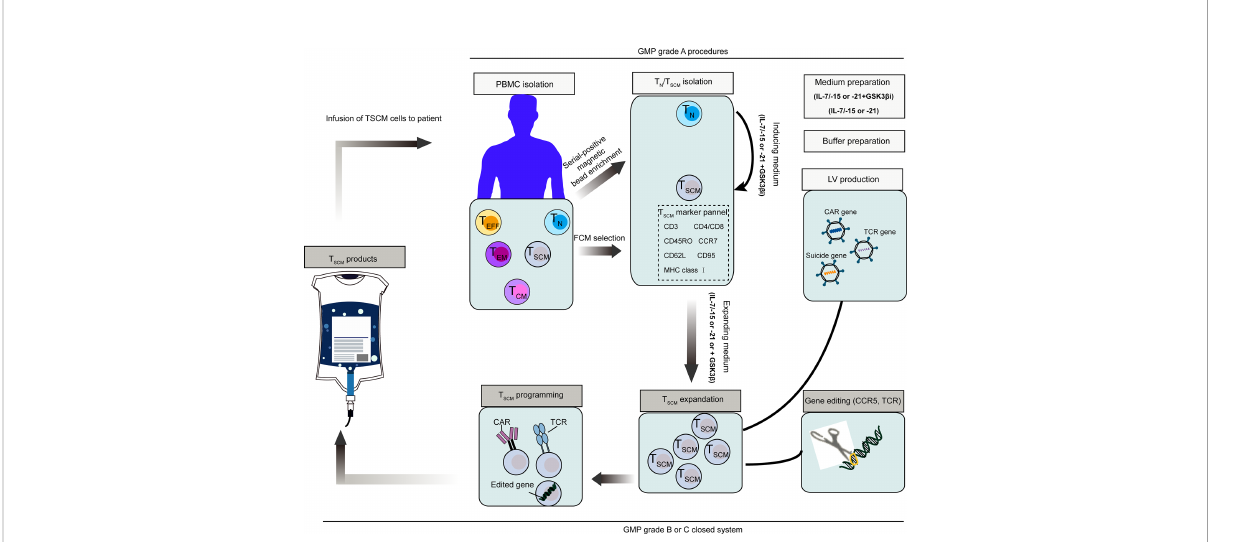
FIGURE 6 Schematic representation of clinical stem cell memory T (T SCM ) cells product and programming process (26, 75, 243). Naïve T (T N) cells were then stimulated to transform to T SCM cells with IL-15, IL-21 and IL-7. To maximize the induction of T SCM , GSK-3 b inhibitor can be used in addition to the above cytokines. T SCM cells can be also isolated directly from PBMCs by a set of markers. Representative programming methods include introducing exogenous genes like speci fi c CAR, TCR and suicide genes, or directly editing endogenous genes. Requirements of GMP grade for main procedures are indicated in the fi gure. PBMC, peripheral blood mononuclear cells, CAR, chimeric antigen receptor, TCR, T cell receptor; GMP, good manufacturing